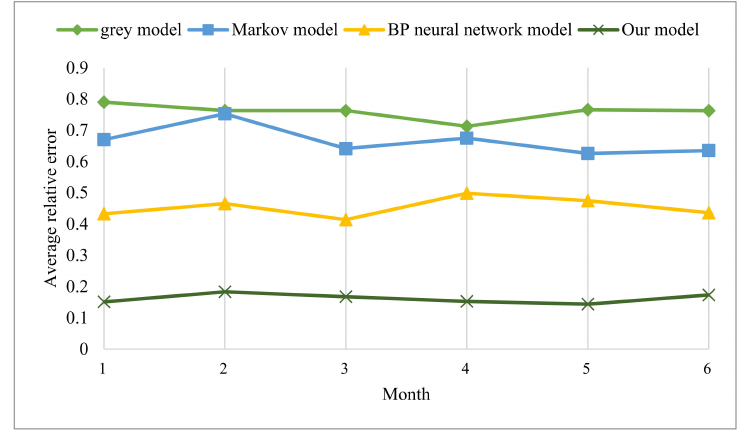
Figure 9. Average relative errors of different prediction